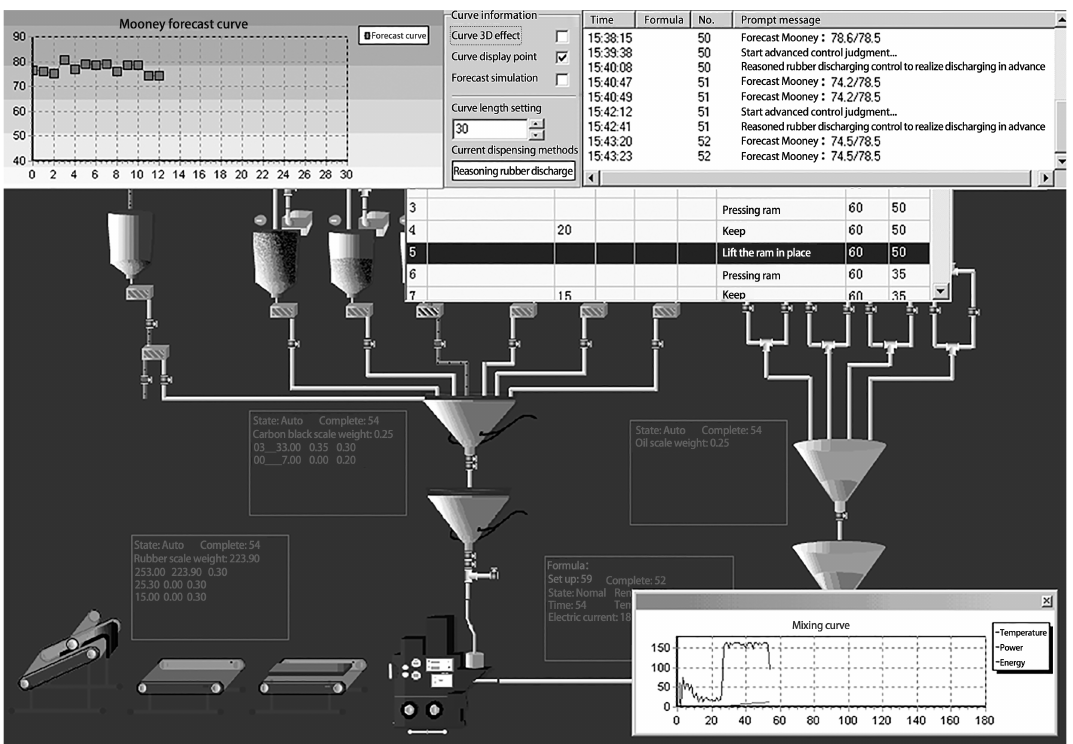
Figure 2: Smart internal mixing system.